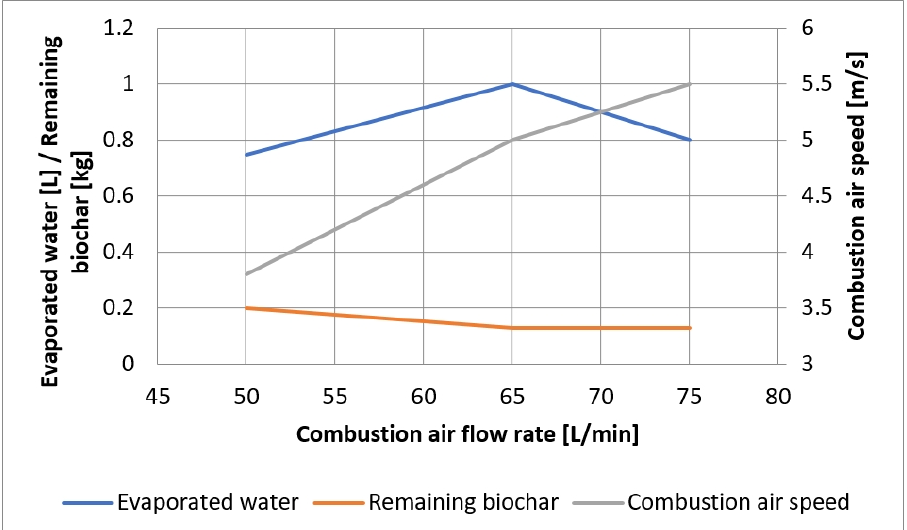
Figure 20. Variations in the amount of evaporated water, amount of remaining biochar, and combustion air speed depending on the combustion air flow rate.